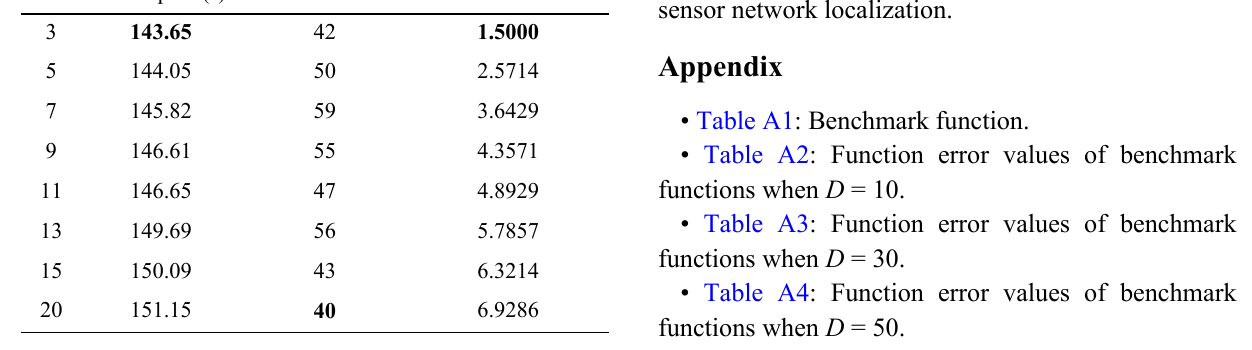
Table A1 Benchmark